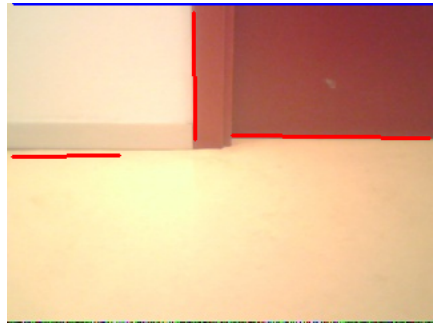
Figure 19. Observation taken to update MCL particles.